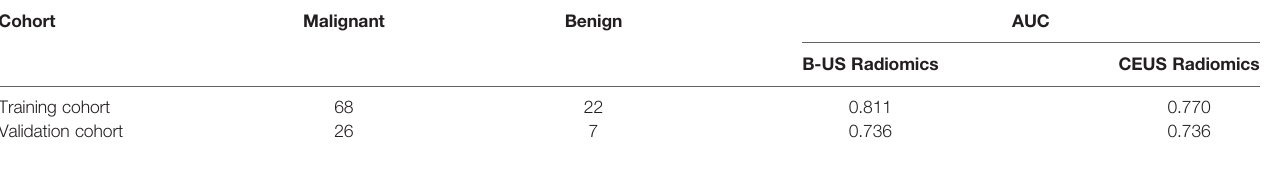
TABLE 3 | Comparison of information in the training and validation